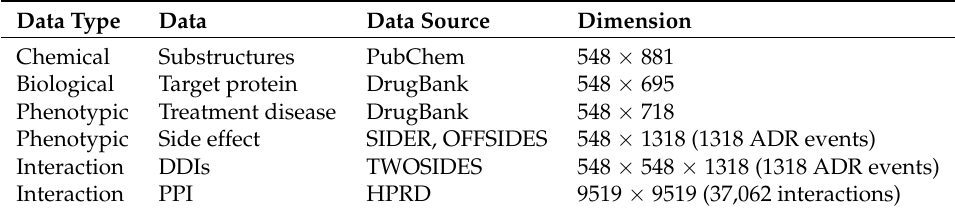
Table 1. Description of the drug data.PPI, protein–protein interaction.